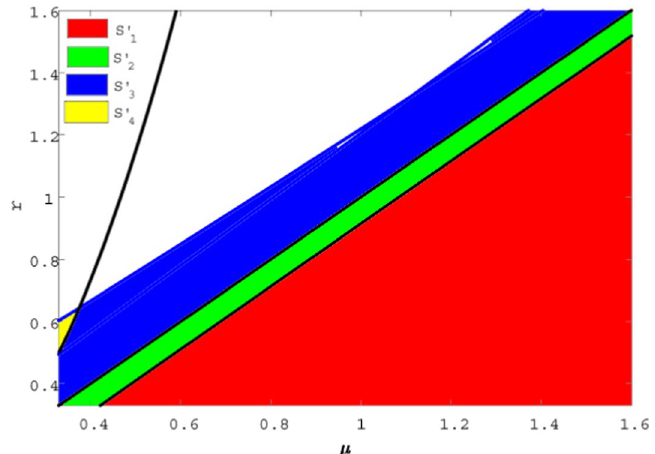
Fig. 13 Existence of stable–unstable region for the fractional-order